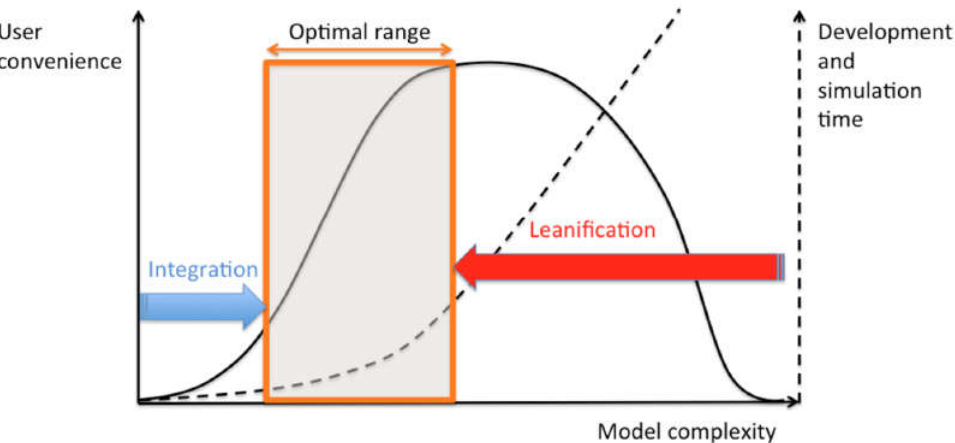
Figure 1. User convenience in relation to the level of complexity. Many water-related problems constitute many interactions. Thus, the art of applied modeling determines an appropriate balance between integration of more processes and variables while avoiding too long development and simulations times. The range indicates that for some cases, very lean and simple models are very convenient (e.g., for exploration of potential solutions and for real-time control applications), whereas for other applications, a higher level of integration is more critical than a fast simulation time.